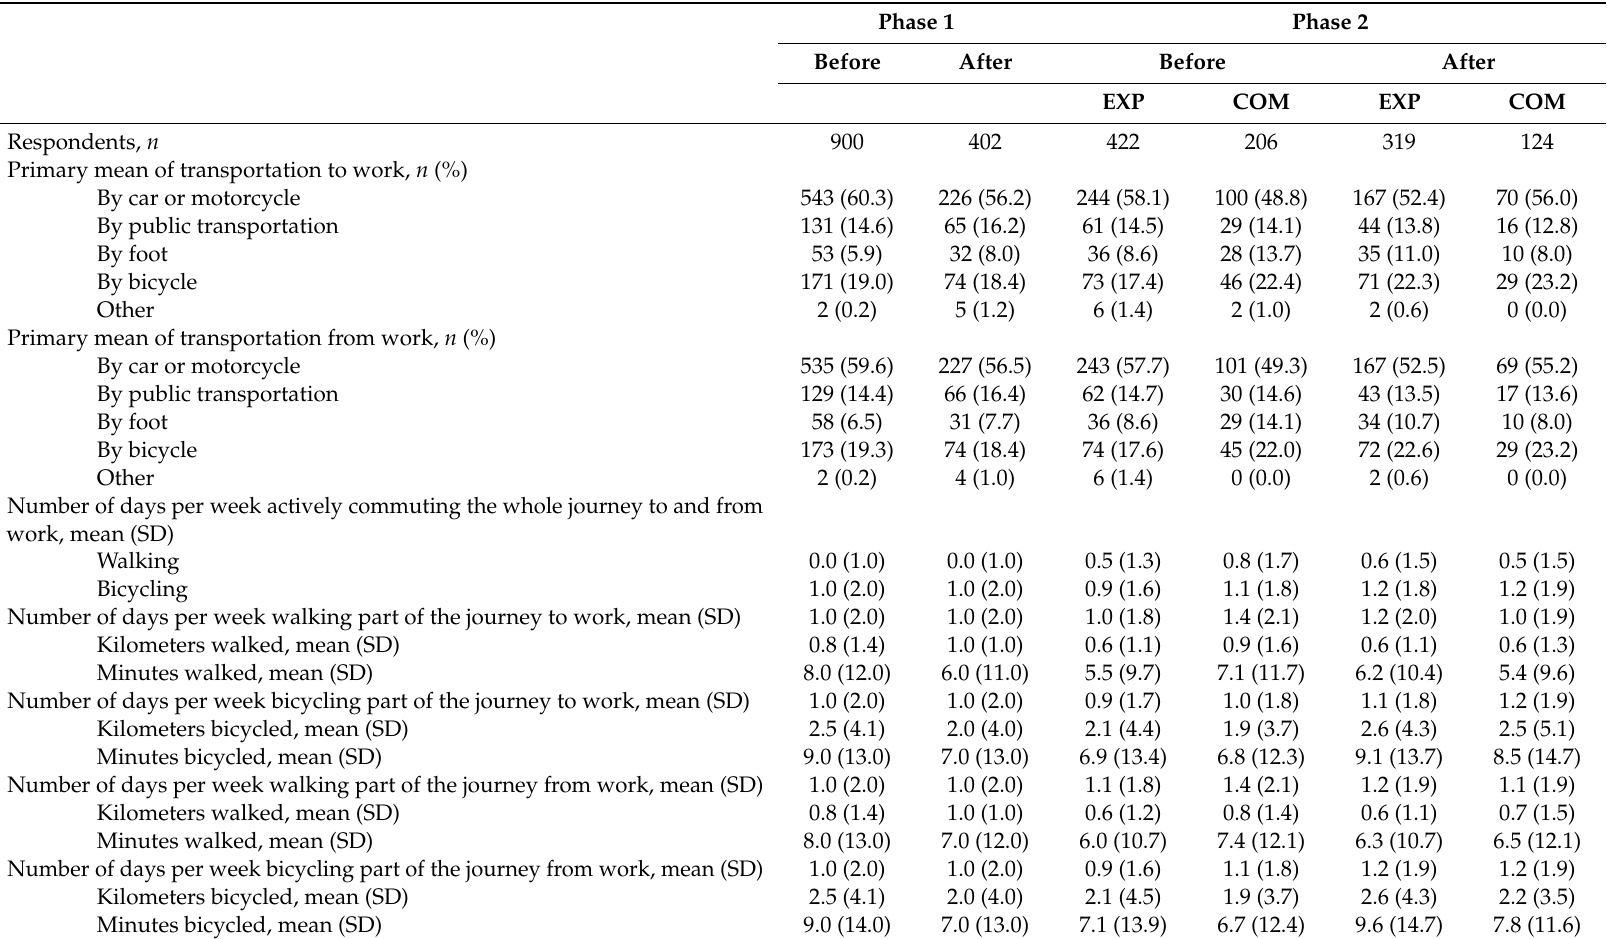
Table 5. Employees’ self-reported ACW before and after environmental strategies in Phase 1 and before and after social and behavioral strategies in Phase 2. EXP: experimental group; COM: comparison